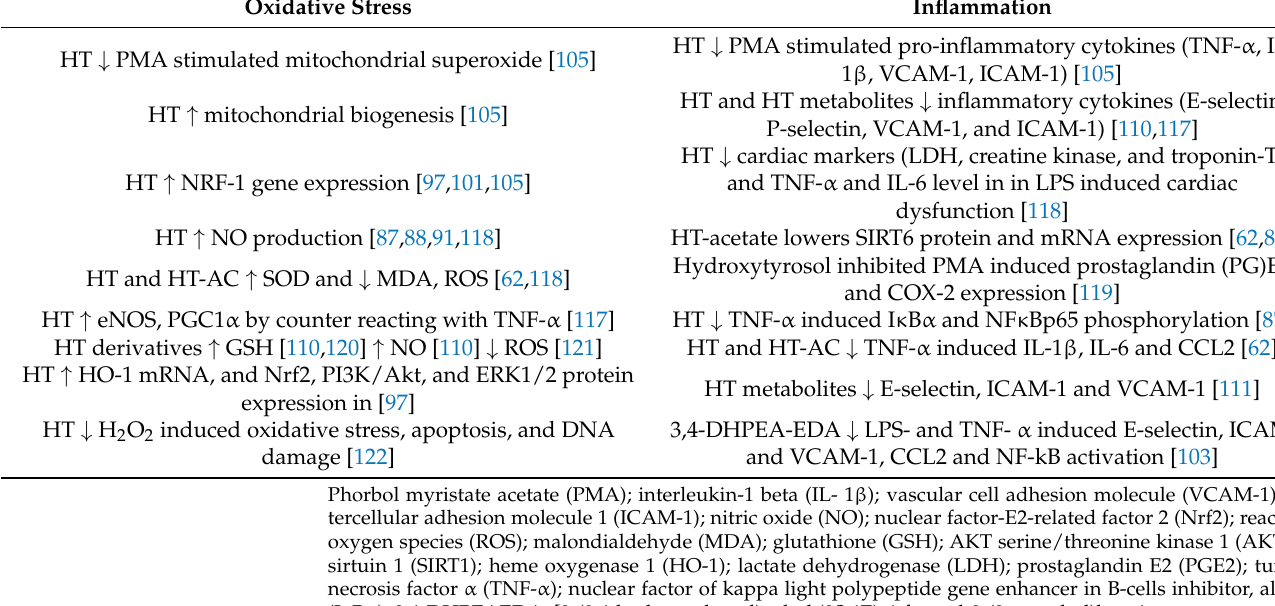
Table 2. Studies on hydroxytyrosol effects on oxidative stress and anti-inflammatory action. Oxidative